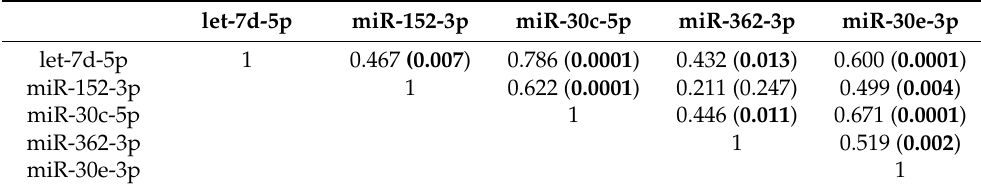
Table 3. Correlation among dysregulated miRNAs in ccRCC patients before (t 0 ) and after surgery (t 1 ). Spearman correlation coefficients between two miRNAs are detailed. Significant p -values are depicted in